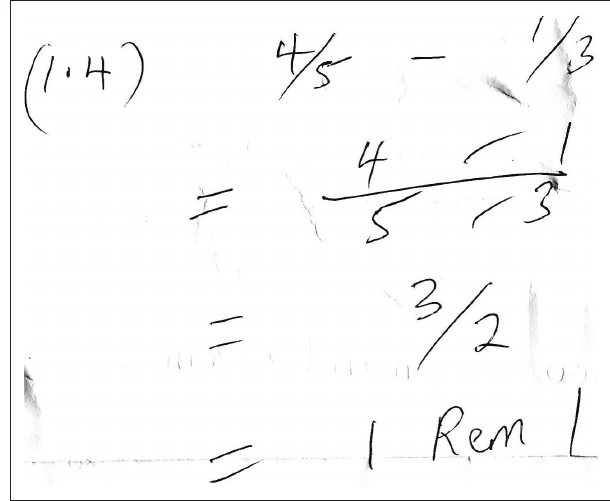
FIGURE 3: The response of T57 to addition of fractions with different denominators. FIGURE 4: The written response of T25 to subtraction of